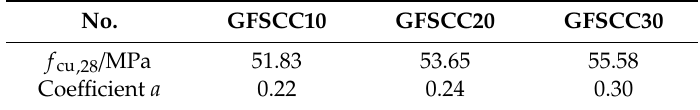
Table 9. Relationship between the coefficient a and the compressive strength.